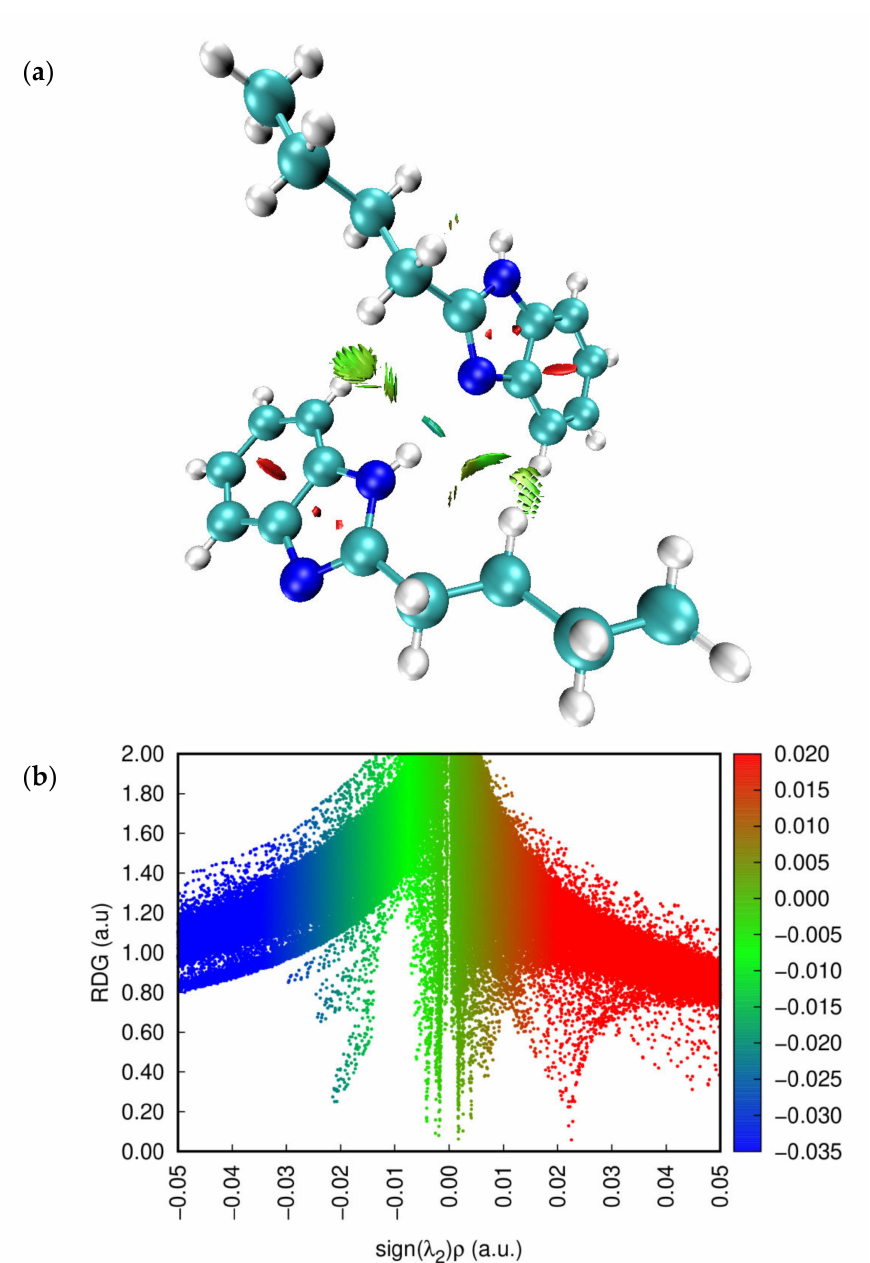
Figure 5. ( a ) VMD graph and ( b ) RDG scatter map of the title